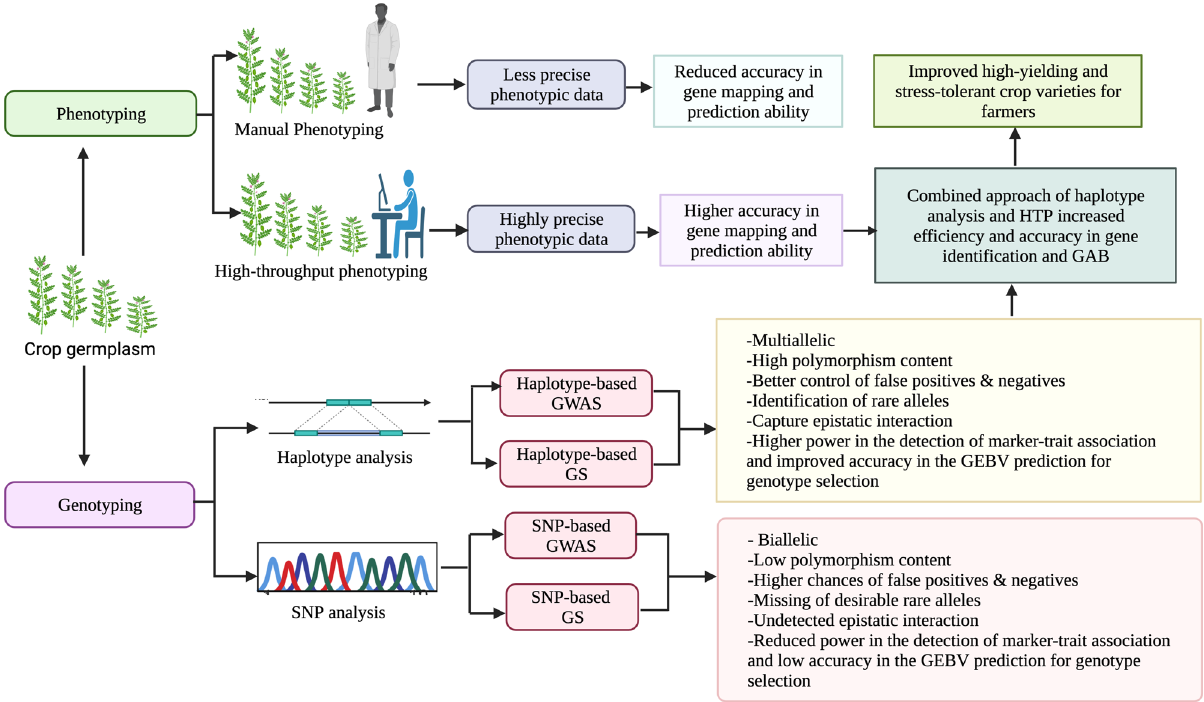
Fig. 2 Mining of SNPs and construction of haplotypes for detecting marker-trait associations (GWAS) and computing genomic estimated breeding values (GS). This diagram describes the comparative potential of the Haplotype-Based GWAS/Haplotype-Based GS in relation to SNP-Based GWAS/SNP- Based GS for the development of improved crop cultivars via genomics-assisted breeding (GAB). It showed that Haplotype-Based GWAS/Haplotype- Based GS in combination with the high-throughput phenotyping (HTP) has great potential to enhance the precision and accuracy in the gene identi fi cation and GAB. The image was created using BioRender